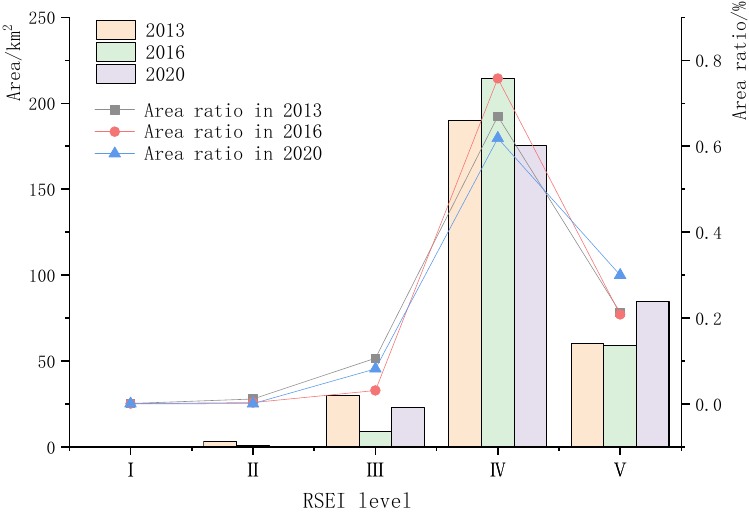
Figure 4. Area and proportion of each ecological class from 2013 to 2020.